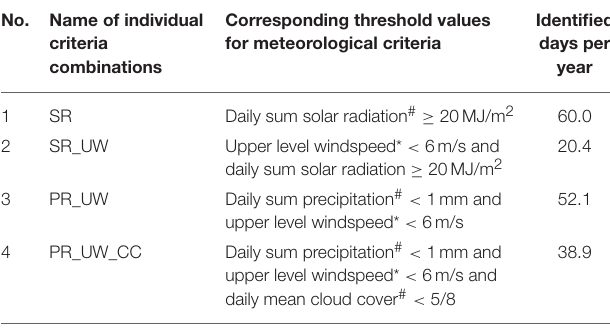
TABLE 1 | Identification criteria combinations with threshold values and average yearly number of days identified from the COSMO-CLM simulation results for the period